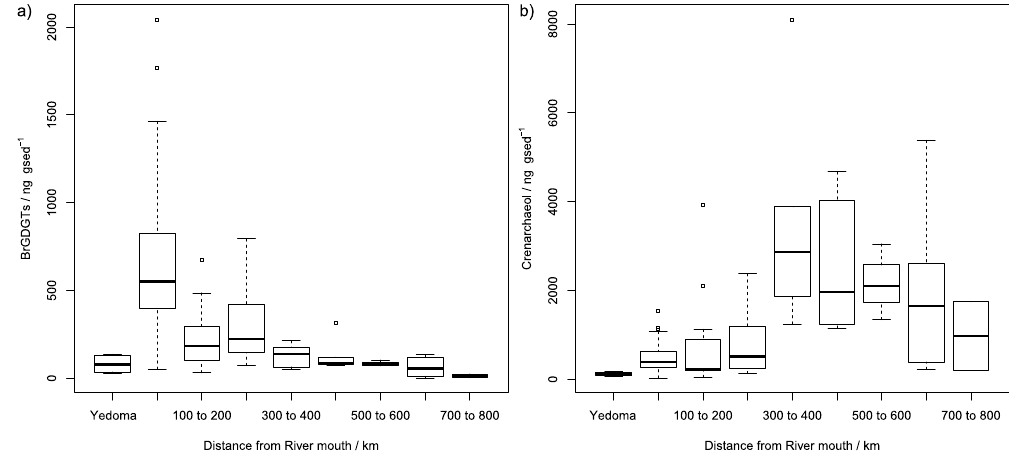
Figure 3. Box plots summarising the concentrations of (a) brGDGTs and (b) crenarchaeol on the ESAS, grouped by distance from river mouths. Concentrations in ice complex samples are also shown. Thick lines show the median values, boxes the 25th and 75th percentiles, whiskers the maximum and minimum values within 1.5 times the interquartile range, and square symbols the outliers beyond this threshold.